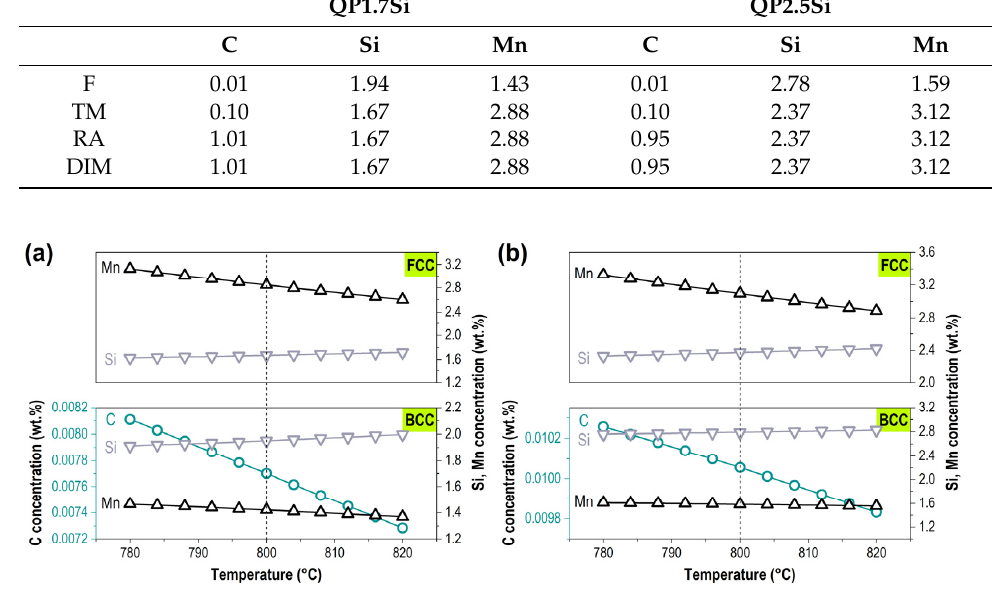
Figure 4. Calculated temperature dependence of the C, Si, and Mn content in FCC and BCC from Thermo-Calc software. ( a ) QP1.7Si; ( b ) QP2.5Si. The solid solution strengthening of RA and F was calculated using Equations (9) and (10), respectively [35].